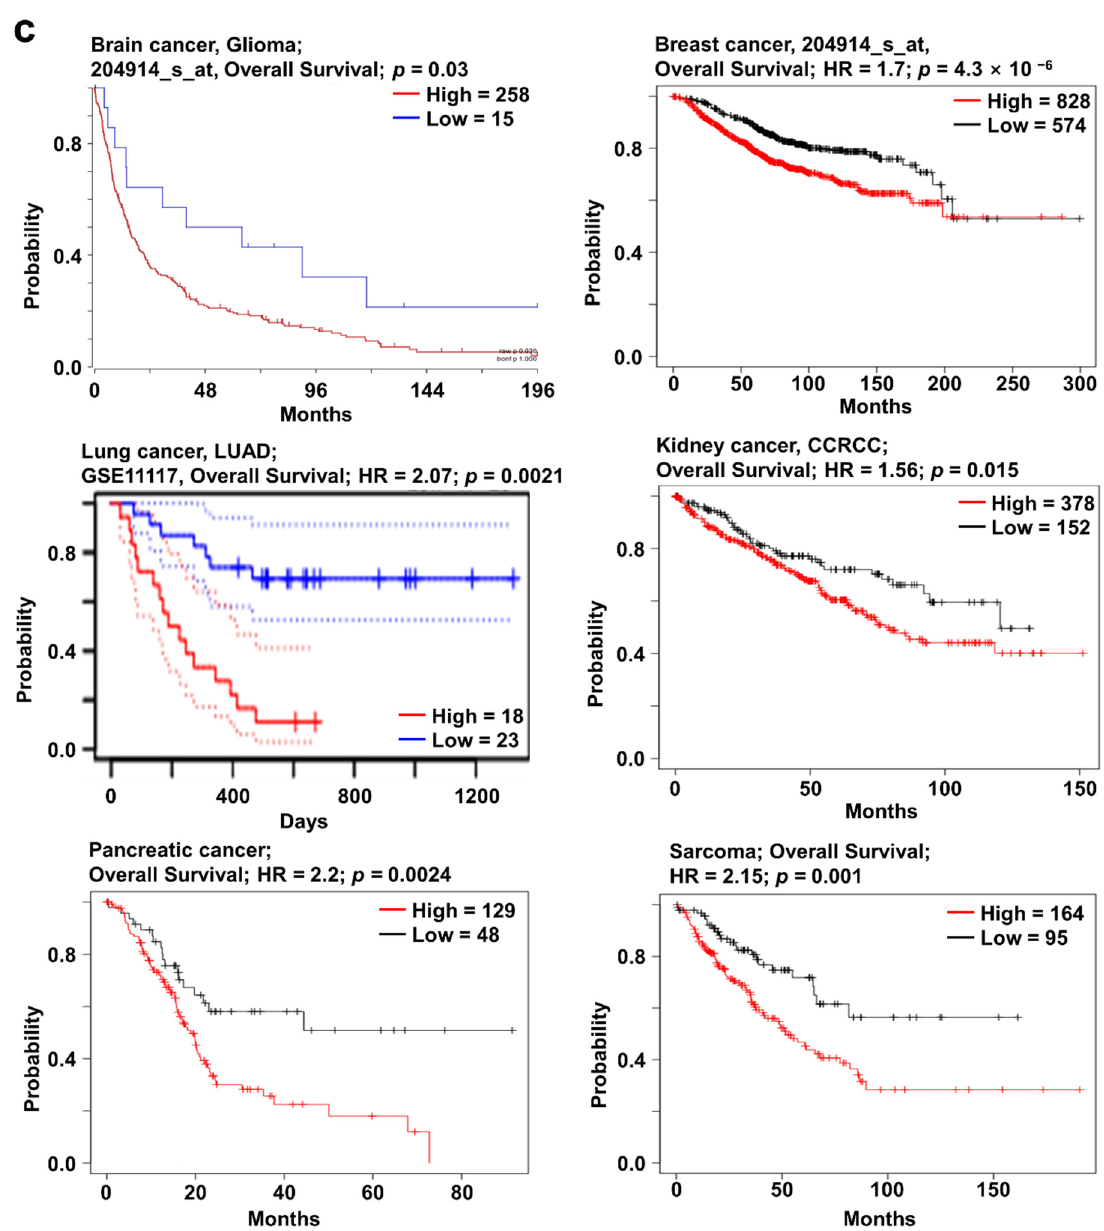
Figure 3. SOX11 expression pattern and patient survival in various cancers. SOX11 expression pattern, alteration frequency of mutations, copy number alteration, and patient survival in various types of cancers. ( a ) Box plots comparing SOX11 expression in normal (left plot) and cancer tissues (right plot) were derived from the Oncomine database. The fold-changes in SOX11 expression in brain, breast, lung, kidney, and pancreatic cancers as well as sarcoma, are shown as box plots. ( b ) Mutations and alteration frequency of SOX11 were determined using the cBioPortal database. The diagram shows SOX11 mutations in different cancer types across protein domains. SOX11 mutations mainly occurred in esophageal cancer with one hot spot (D233 del/2_D233 del) representing common founder mutations. The alteration frequency of SOX11 was determined using cBioPortal and is shown at the bottom. Only those cancer types with more than 100 samples and an alteration frequency of >2.73% are shown. The alterations comprised deletions (blue), amplification (red), or mutation (green). ( c ) Survival plots comparing patients with high (red) and low (blue) SOX11 expression in various cancer types were plotted using the Kaplan–Meier plotter, PrognoScan, and R2 databases. Patient survival analysis was performed using a threshold Cox p- value of <0.05. Abbreviations. GBM: glioblastoma; DBC: ductal breast carcinoma; CCRCC: clear cell renal cell carcinoma; MRCLS: myxoid/round cell liposarcoma; PC: pancreatic carcinoma.